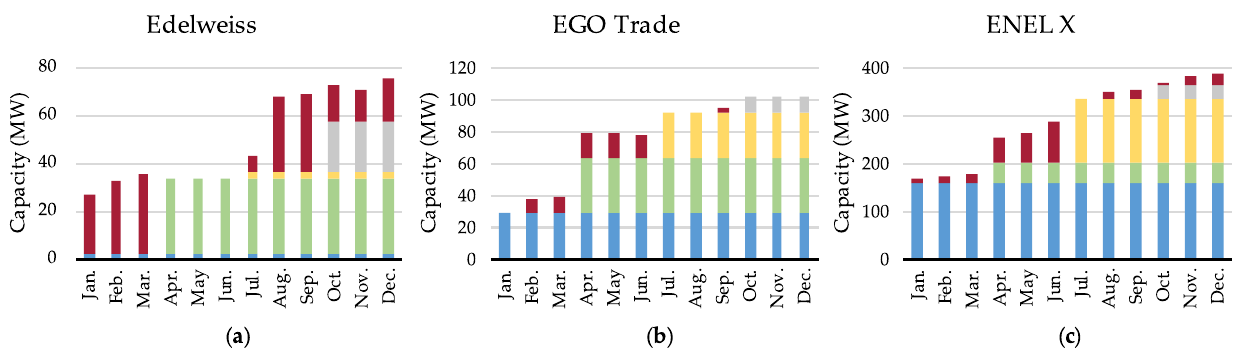
Figure 6. Capacity assignment through different auction types during 2019 for selected companies, namely ( a ) Edelweiss Energia SpA, ( b ) EGO Trade SpA and ( c ) Enel X Italia SpA.